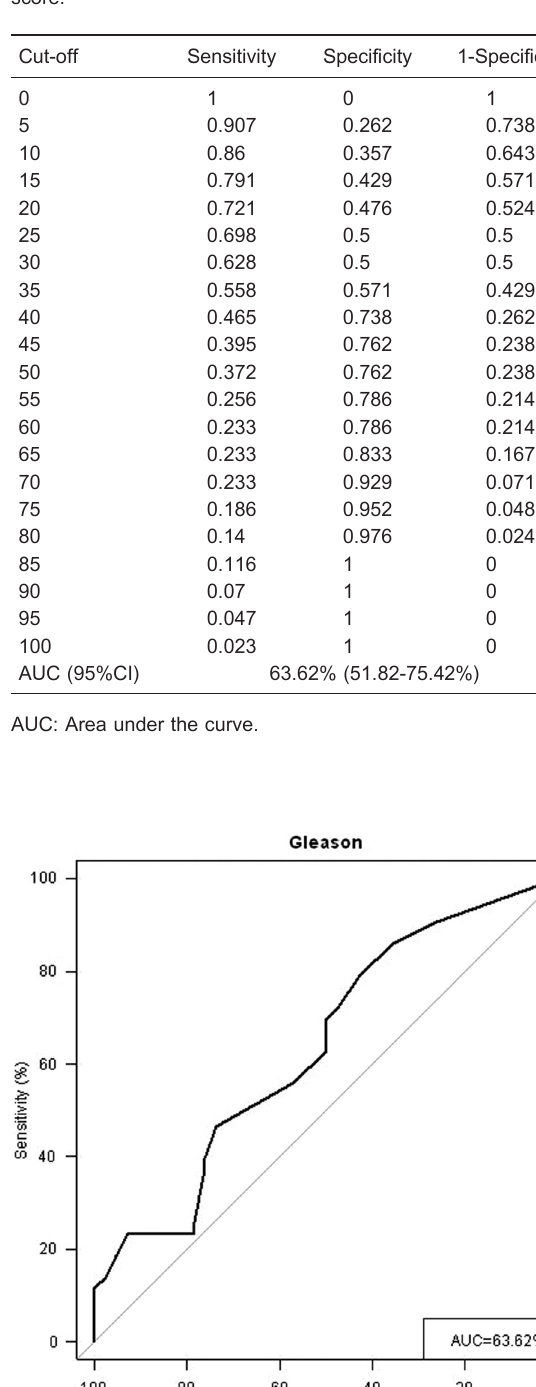
Table 2. Receiver operating characteristic curves for Gleason score.